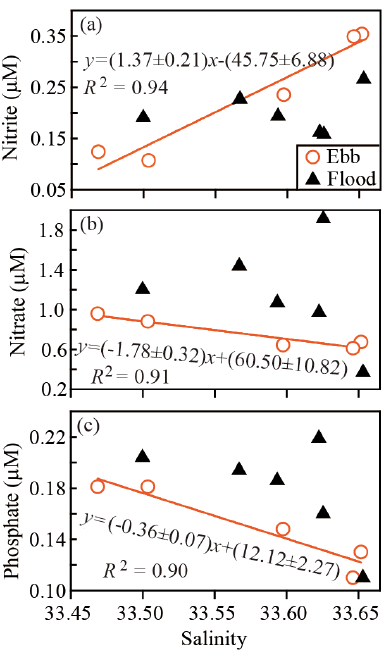
Figure 8. Behaviors of nutrients with salinity during the ebb flow and flood tide of the spring tide at station CT. (a) Nitrite, (b) nitrate, and (c) phosphate.